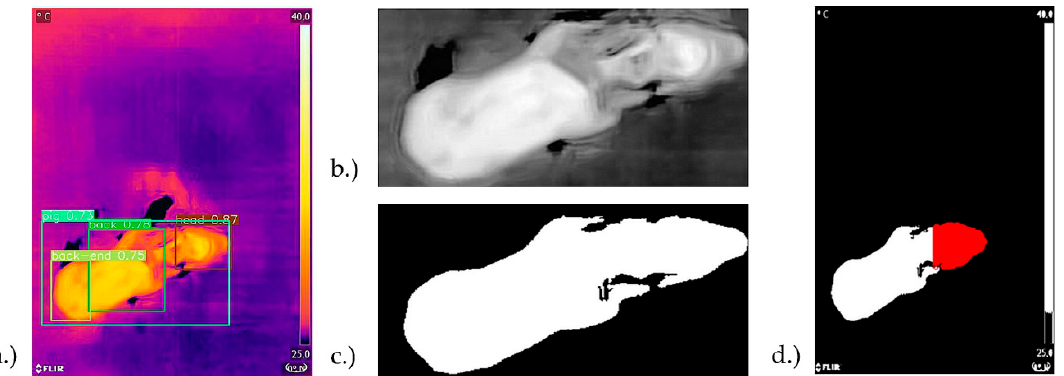
Figure 2. Example Otsu algorithm for the head of a piglet: ( a ) shows the four bounding box detections of YOLOv3-SPP; ( b ) is an image of the area “piglet” after gray value conversion (0–255); ( c ) shows a binary image of the piglet, after thresholding with Otsu algorithm on image ( b ). Image ( d ) shows the overlap of the white foreground area ( c ) and the detected “head bounding box area” from ( a ). The pixels inside the red area are used for further calculations of the head.